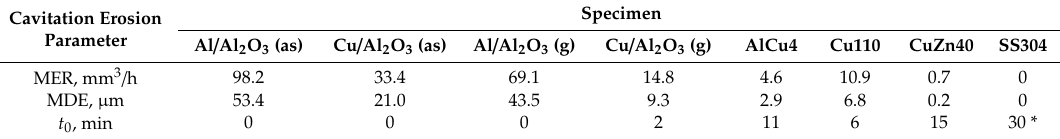
Figure 6. Comparison of the eroded surfaces and cross-sectional profiles of ground samples (different range of depth of the Y-axis in the profilograms), 30 min of cavitation erosion testing; as-sprayed (as) and ground (g). Table 3. Cavitation erosion indicators of tested MMC coatings and metal